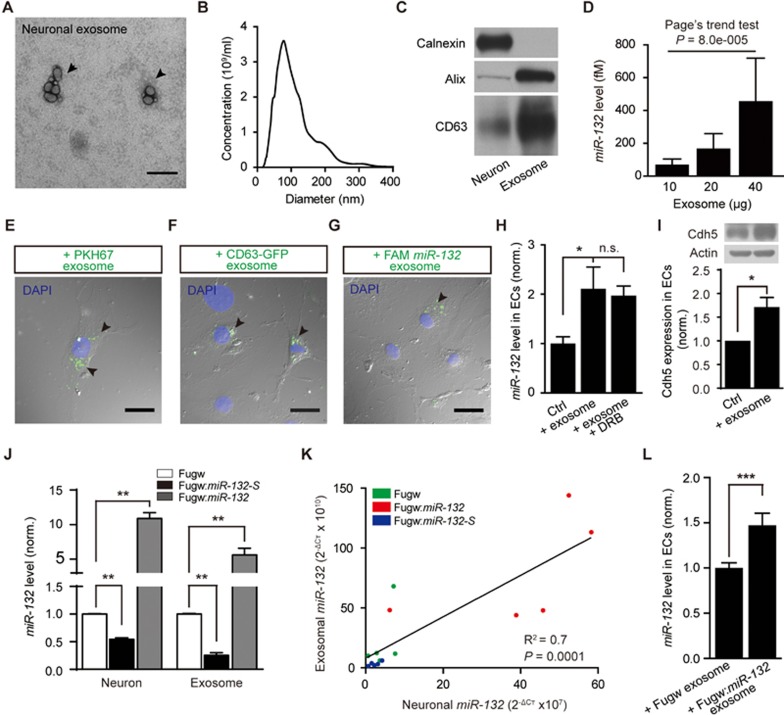
Neuronal exosomes transfer miR-132 from neurons to ECs. (A-C) Characterization of neuron-derived exosomes by transmission electron microscopy (TEM) (A), nanoparticle tracing analysis (B) and Western blotting with equal amounts of samples (C). The exosomes were isolated from the conditioned medium of cultured primary rat cortical neurons. Both Alix and CD63 are exosomal markers, and Calnexin is an endoplasmic reticulum marker. (D)
MiR-132 level measured with different amount of neuronal exosomes. The experiments were repeated five times. (E, F) Internalization of PKH67 (E) or CD63-GFP (F) labeled neuronal exosomes (arrowheads) into the mouse brain microvascular EC line (b.End3). DAPI staining (in blue) was performed to visualize the nuclei of b.End3 cells. (G) Existence of FAM-tagged miR-132 (arrowheads) in b.End3 cells, which were incubated with exosomes isolated from neurons transfected with FAM-tagged miR-132. (H) Relative level of miR-132 in b.End3 cells incubated with PBS (“Ctrl”), neuronal exosomes alone (“+ exosome”) (200×), or neuronal exosomes plus the RNA polymerase II inhibitor DRB (“+ exosome + DRB”) (200×). The experiments were repeated nine times. (I) Relative expression of Cdh5 in human umbilical vein endothelial cells (HUVECs) incubated with PBS (“Ctrl”) and neuronal exosomes (“+ exosome”) (200×). The experiments were repeated four times. (J, K) Coordinated changes of miR-132 level in the cultured rat cortical neurons and their secreted exosomes. The line in K represents linear regression with P = 0.0001. Cultured neurons were transfected with Fugw:miR-132-S or Fugw:miR-132 to, respectively, down- or up-regulate miR-132 levels, and transfection with Fugw served as a control. The experiments were repeated five times. (L) Relative level of miR-132 in b.End3 cells incubated with exosomes isolated from neurons transfected with Fugw vector (“Fugw exosome”) or Fugw:miR-132 (“Fugw:miR-132 exosome”) (50×). The experiments were repeated three times. Scale bar, 100 nm (A), 25 μm (E-G). Error bars, SEM. n.s., no significant; *P < 0.05, **P < 0.01, ***P < 0.001 (Page's trend tests were applied for D; one-way ANOVA with post hoc Tukey's multiple comparison test for H and J; unpaired two-tailed Student's t-test for I and L).